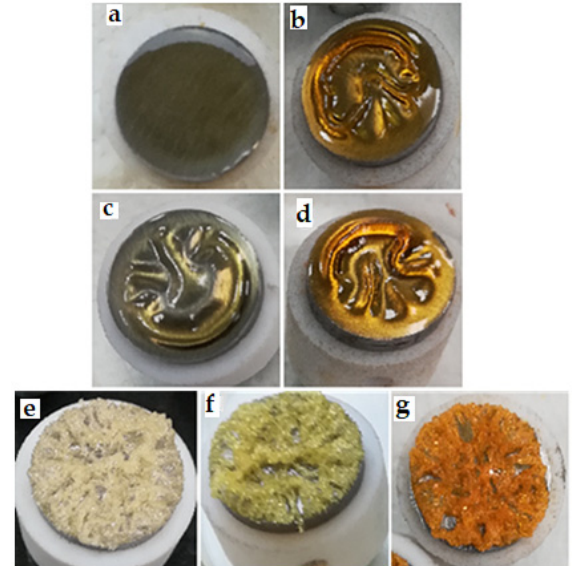
Figure 1. The spicemens after incubation at 90 °C temperature: hempseed oil—24 h ( a ), 240 h ( b ); linseed oil—24 h ( c ), 240 h ( d ); tung tree oil 2 h ( e ), 24 h ( f ), 240 h ( g ). Molecular labile cross-links give rise to highly stable networks that are the basis for the hydrophobic and protective coating. Autoxidation of the unsaturated fatty acids is assumed to increase the oil mass. ◦ The incubation for 240 h at 90 C led to a di ff erent level of the autoxidation and thereby the weight increase (Table 2). As mentioned above, the slowest autoxidation was observed for the hempseed oil due to the presence of the antioxidants such as vitamin E